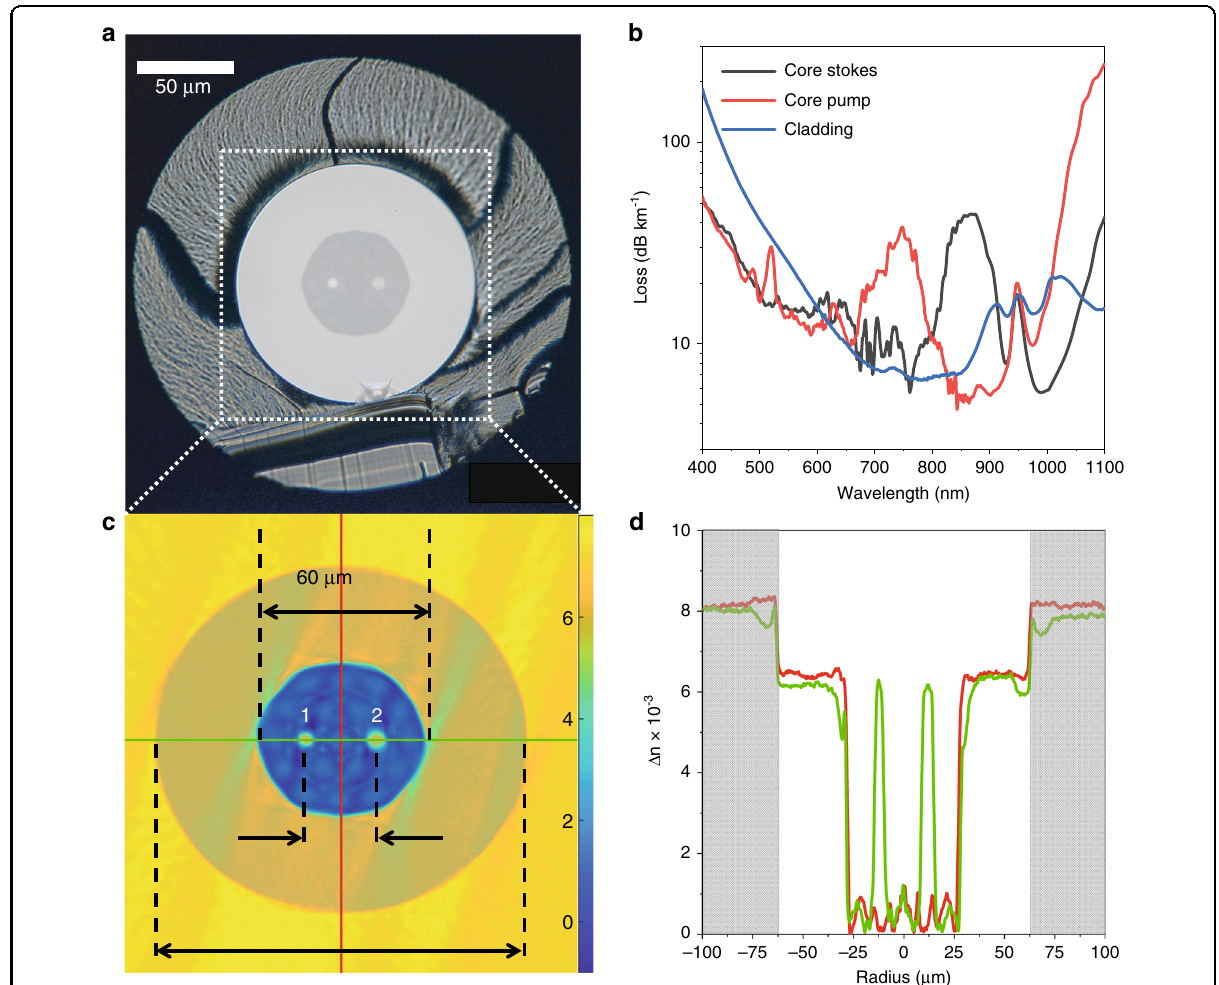
Fig. 1 DCDC fi ber cross section, fi ber attenuation and refractive index pro fi le characterization. a microscopic image of the front facet of the manufactured DCDC fi ber consisting of two single-mode cores made of pure silica separated by 24 µm and 4.8 µm (core 1, cut-off wavelength 836 nm) and 6.3 µm (core 2, cut-off wavelength 970 nm) in diameter for guiding pump and Stokes laser at 795 and 1030 nm, respectively, and a fl uorine-doped inner cladding of 60 µm diameter and a pure silica double-clad of 125 µm diameter for signal collection, coated with a fl uorine-doped polymer of 230 µm diameter ( n = 1.363 at 852 nm) ( b ) fi ber attenuation of the two cores and the outer cladding. The attenuation per km fi ber length of core 1 is 11 dB at 795 nm, of core 2 8.5 dB at 1030 nm, and the one of the outer cladding 185 dB at 400 nm and 7.5 dB at 700 nm. Maxima in transmission loss correspond to the modal cut-off of the individual cores. c Refractive index Δ n of the fi ber relative to fl uorine-doped pure silica measured in 2D at 633 nm. d Cross-sections of the refractive index pro fi les at the red and green lines indicated in ( c ). The deviation from the step refractive index pro fi le for the green graph is an artefact resulting from the reconstruction algorithm. The grey area marks the region of the polymer coating of n = 1.363, which was removed for the